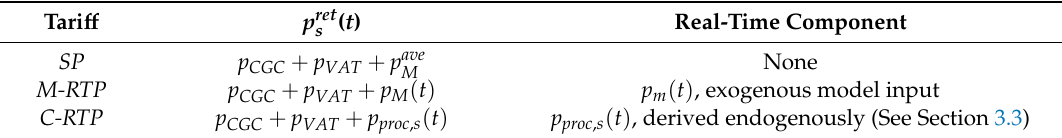
Table 1. Overview of constructed tari ff